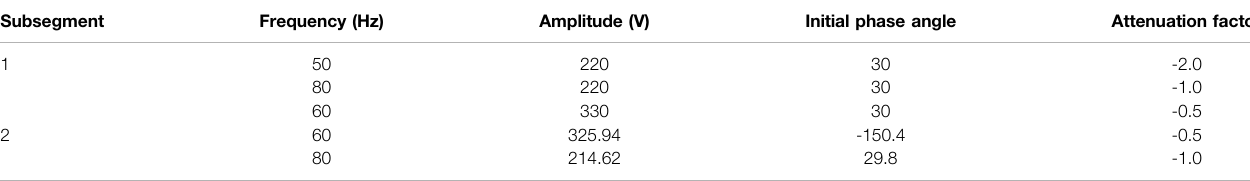
TABLE 2 | Component parameters of subsegment based on